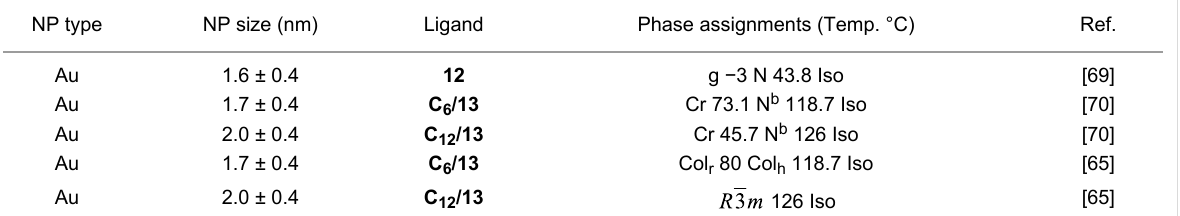
Table 2: Summary of the phase behaviour of the hybrid NPs with laterally substituted ligands discussed in the text. a NP